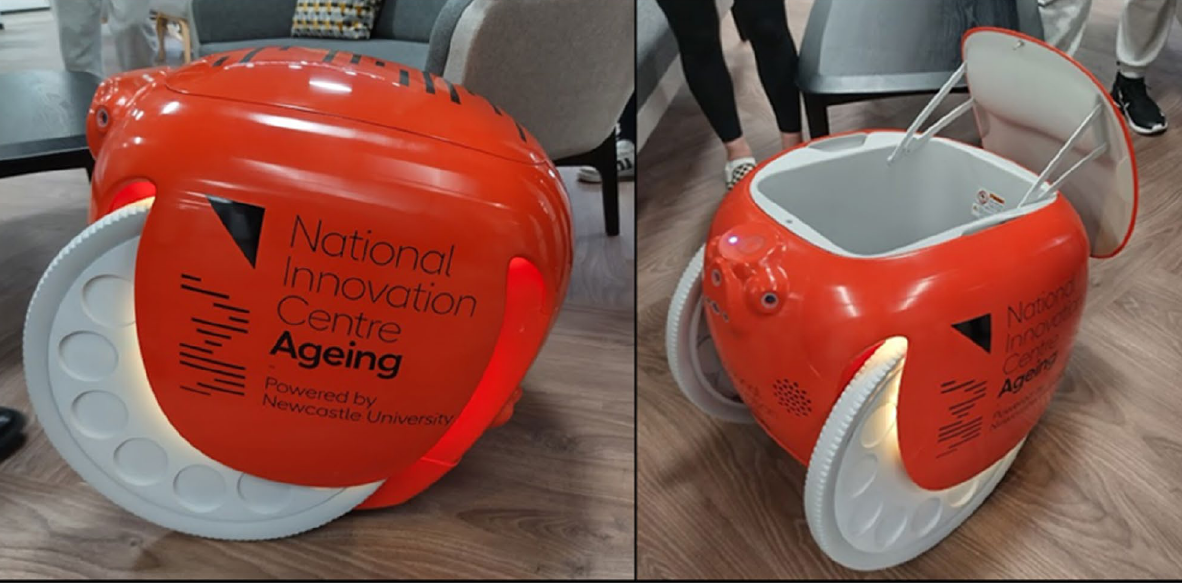
Figure 1. The human-following robot (Gita) used in this